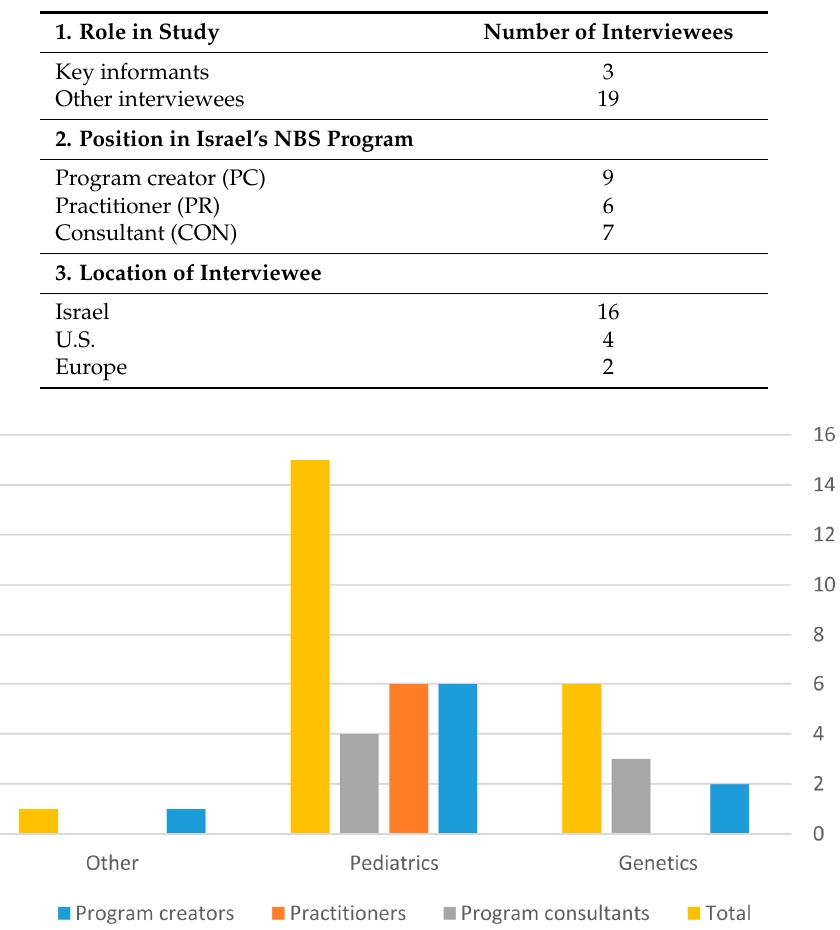
Figure 1. Primary specialty of program creators, practitioners, and consultants ( N = 22).